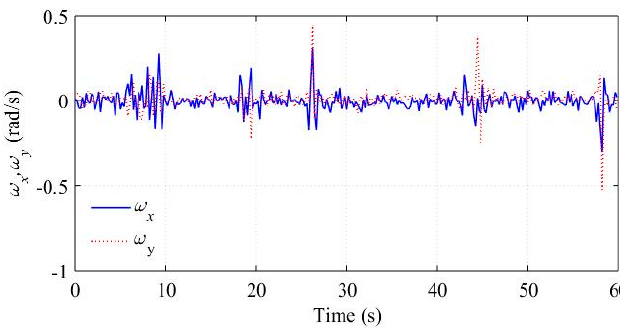
Figure 8. Figure 8. ω x and ω y in bumps and ditches experiment.